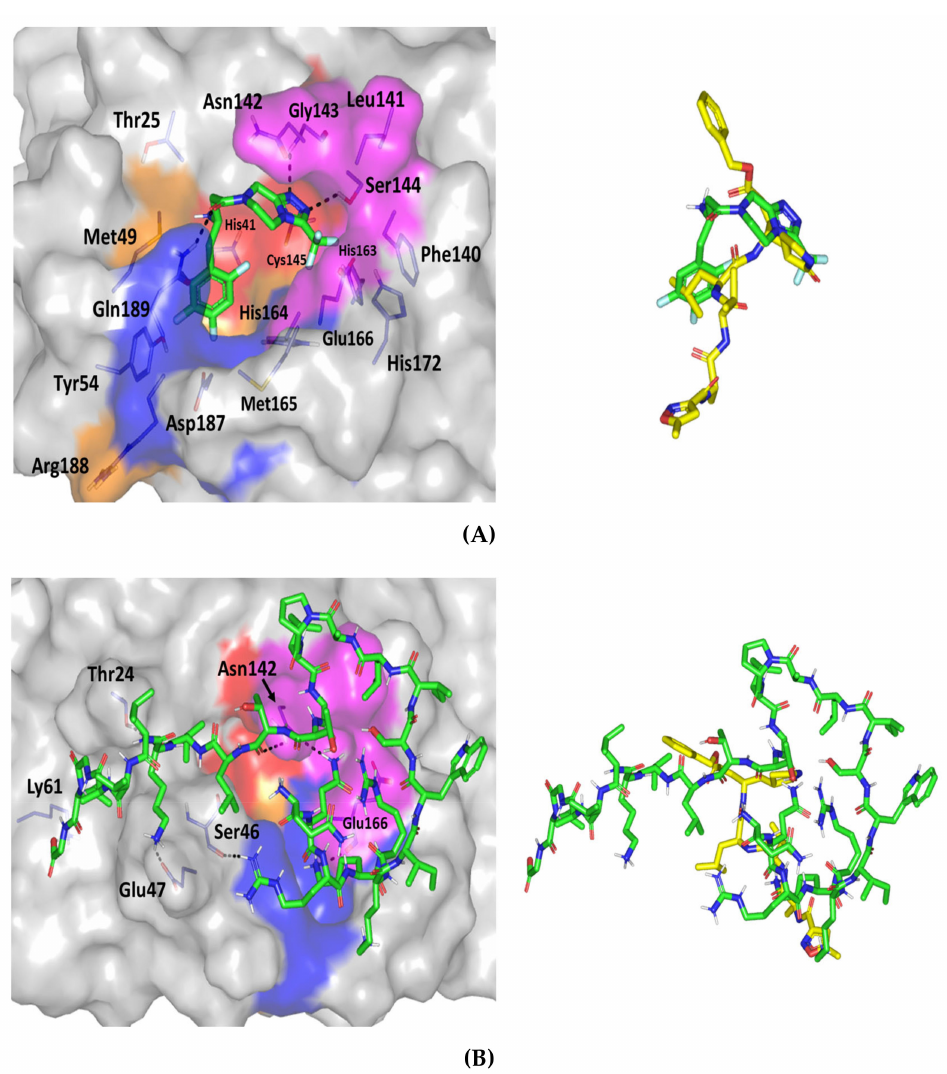
Figure 8. Docking poses sitagliptin ( A ); melittin formulation proteinomimetic ligand ( B ), within the SARS-CoV-2 3CL pro active site (PDB code: 6lu7). Left panels depict the suggested ligand-target complexes showing docked ligands as green sticks, while 3CL pro target (gray surface) with different colored sub-pockets (S1’ = red; S1 = magenta; S2 = orange; S3 = blue). Overlaid conformations of docked ligands (green sticks) and crystallized N3 (yellow sticks) are depicted at rights panels. The ligand–protein hydrogen interactions are represented as black dashed-lines. Residues (lines) located within 5 Å radius of bound ligands are colored in accordance with sub-pocket being labeled with sequence